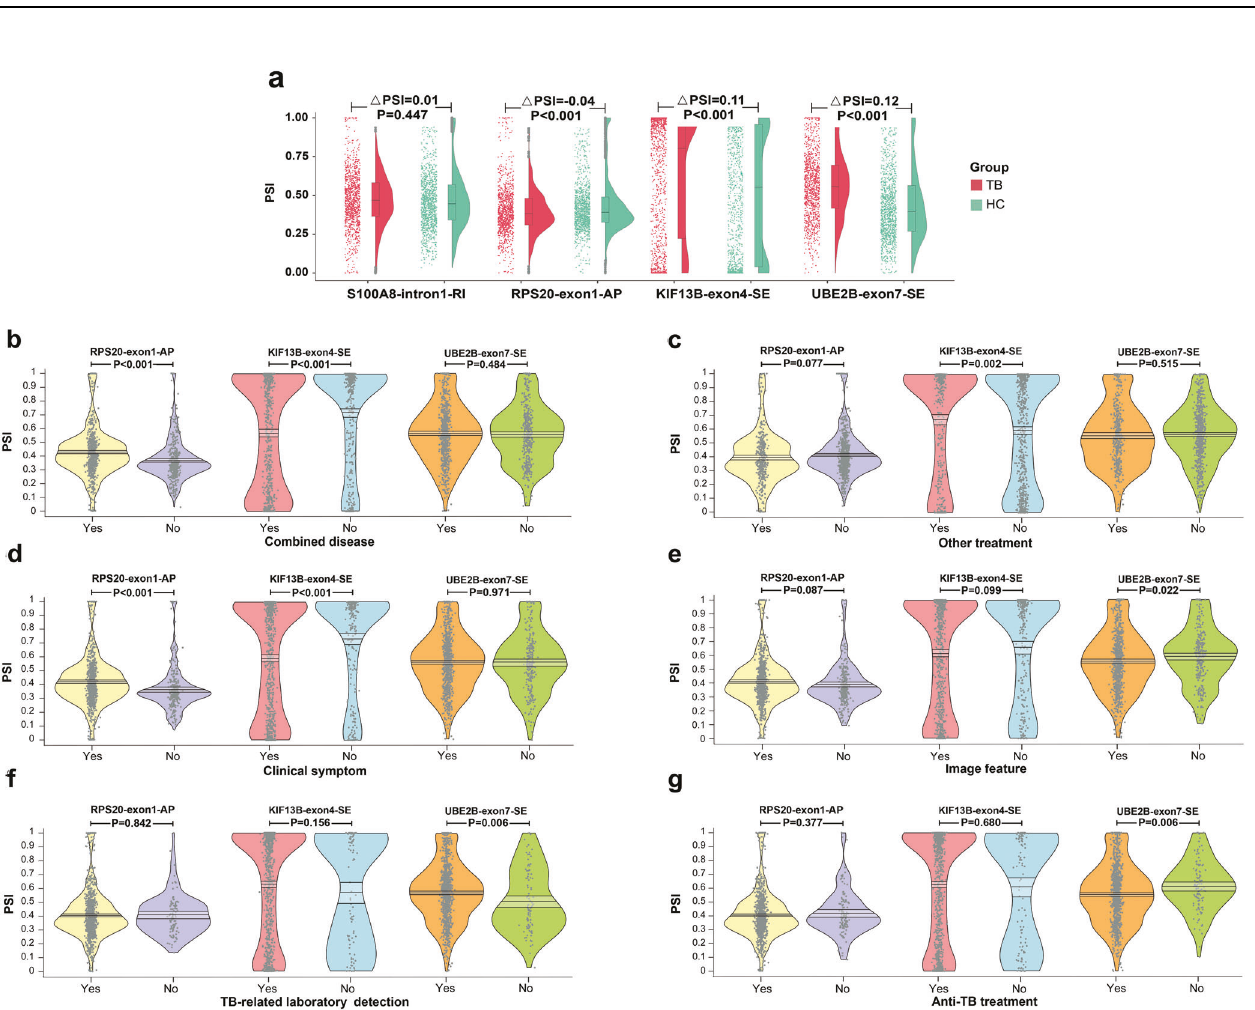
Fig. 2 The splicing of selected four events in the in-house cohort-2. a The splicing of selected four events in the in-house cohort-2. The left scatters and right violin plots showed the distribution of PSI values and data density, respectively. The middle boxplot showed the median, two hinges, two whiskers, and outlying points. b – g Pirate plots of the target three splicing events in subgroups divided by combined disease, other treatment, clinical symptom, image feature, TB-related laboratory detection and anti-TB treatment, respectively. Points represented the raw data. The vertical bar and bands showed the mean and 95% highest density interval, respectively. The bean exhibited the data density. PSI percent spliced in, TB tuberculosis, HC healthy control, S100A8 S100 Calcium Binding Protein A8, RI intron retention, RPS20 Ribosomal Protein S20, AP alternate promoter, KIF13B Kinesin Family Member 13B, SE skipping exon, UBE2B Ubiquitin Conjugating Enzyme E2 B